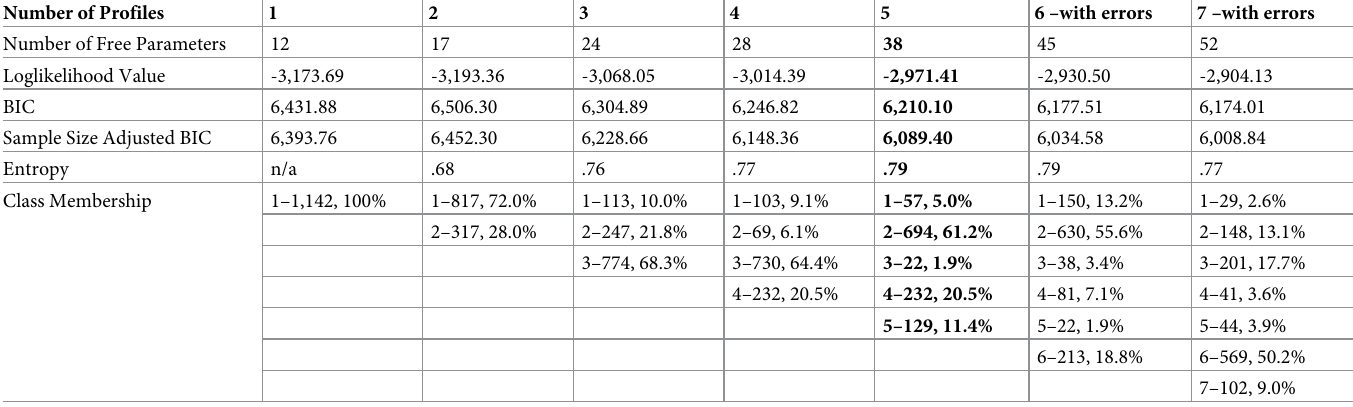
Table 2. Fit indices and class membership for latent